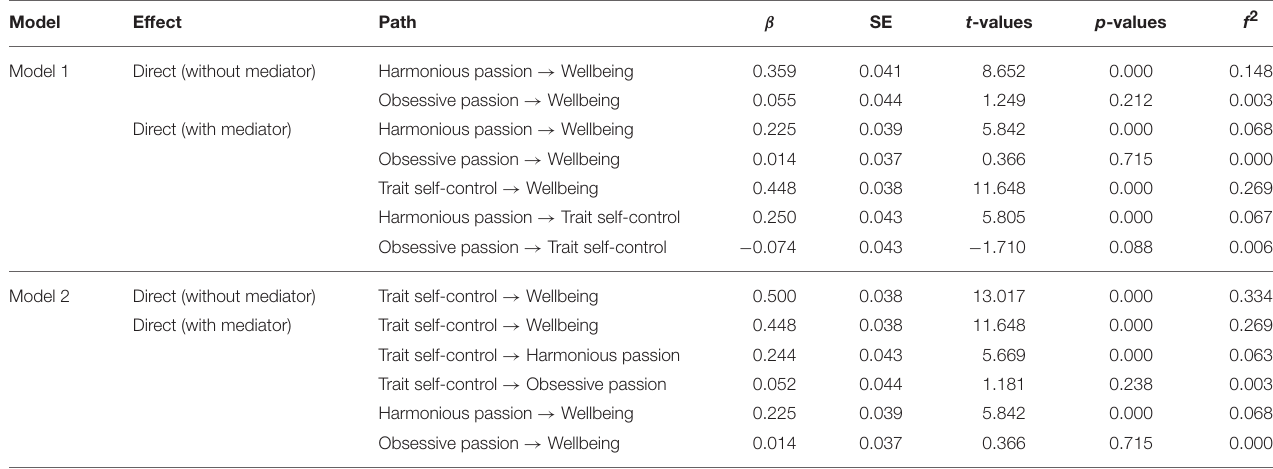
TABLE 4 | Path estimates of the two models.